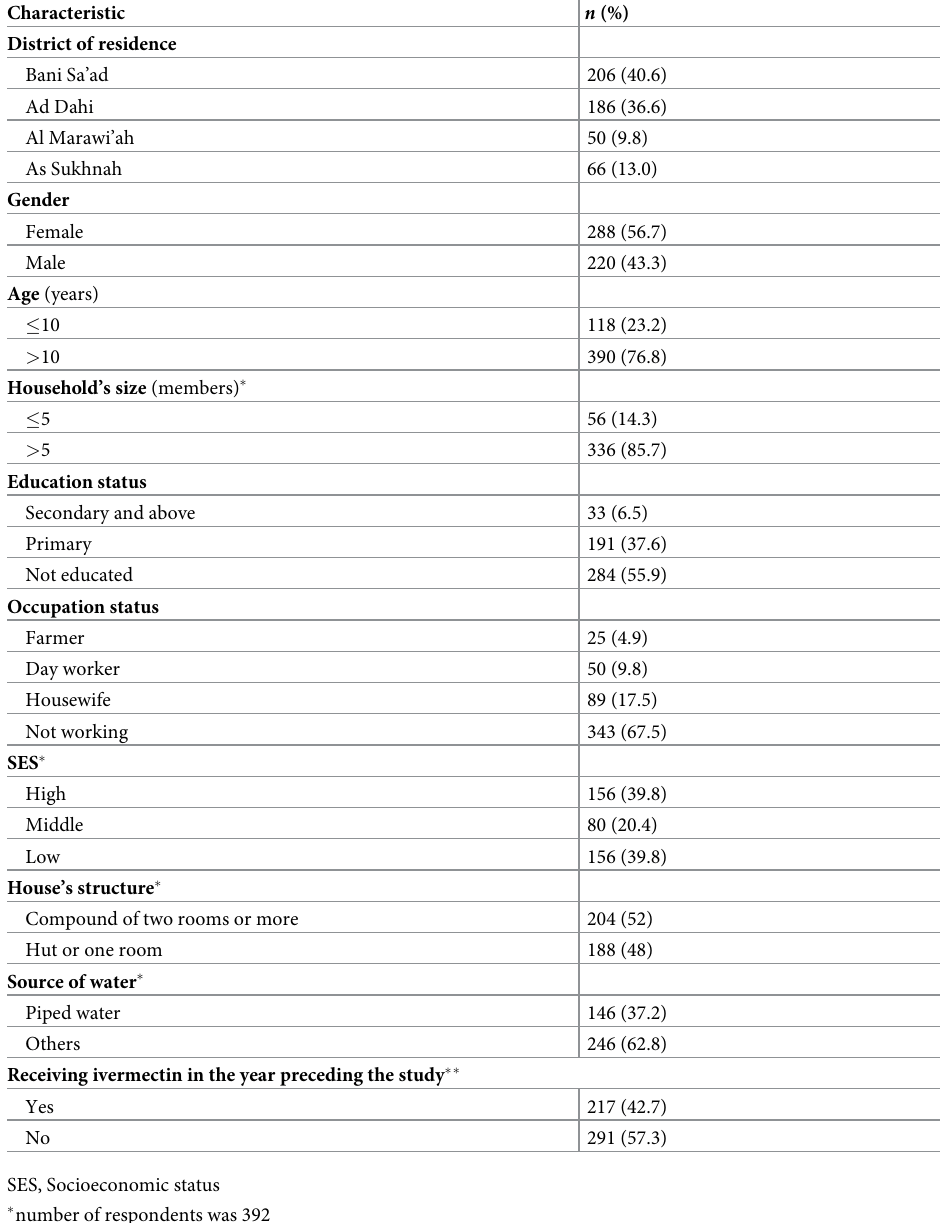
Table 1. Characteristics of study participants (N =